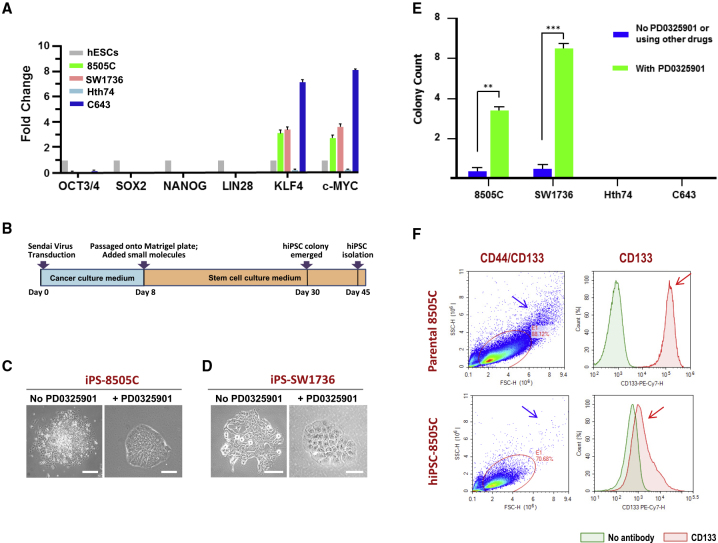
Reprogramming Virulent ATC Cells into hiPSCs(A) Stemness-related gene expression of cancer cells compared with hESCs, the gold standard of epiblast-modeling cells. Gene expression levels in the cancer cells were normalized to that in the hESCs. The expression levels of pluripotency markers OCT-3/4, SOX2, NANOG, and LIN28 were virtually undetectable in all four parental cancer lines compared with their levels in hESCs; the findings were the same for the other standard pluripotency markers SSEA-4, TRA-1-60, and TRA-1-81, shown by immunocytochemistry in Figure S3. By contrast, expression of the oncogenes KLF4 and cMYC was ∼2–3 times higher in both the 8505C and SW1736 ATC lines and 7–8 times higher in C643 compared with their levels in hESCs; only Hth74 had KLF4 and cMYC expression levels lower than in hESCs. Three independent experiments were performed.(B) Schematic of the Sendai viral reprogramming procedure. See Figure S1 for efficiency of episomal vector transfection.(C and D) Colony morphology of a cancer-derived hiPSC is more like that of an hESC with tonic RAS suppression. Scale bars, 100 μm.(E) Comparison of the number of hiPSC colonies formed for each cancer-derived hiPSC without and with Ras suppression. RAS pathway inhibition not only improves colony morphology but also increases the number of hESC-like colonies. The result was reproducible in three independent experiments.(F) Cancer stem cells (CSCs) present in the parental ATC lines are not simply selected and expanded by the reprogramming process. Representative flow cytometry data are shown in two different formats for the well-accepted CSC markers CD133 and CD44 for the representative ATC line 8505c. The upper panels show CSC marker expression by the parental cancer population. The lower panels show expression by the ATC-derived hiPSC population. The right panels, assay for expression of CD133. Note that a red CD133 peak is present in the cancer population (red arrow) but is indistinguishable from the green negative control peak in the hiPSC population. The left panels, assay for cells with dual expression of CD133 and CD133. The cancer cell population has a prominent dual-positive bin (blue arrow) which largely disappears in the cancer-derived hiPSC population (blue arrow). All data were collected from three independent experiments. Error bars indicate the standard error of the mean.Related to Figures S1–S3